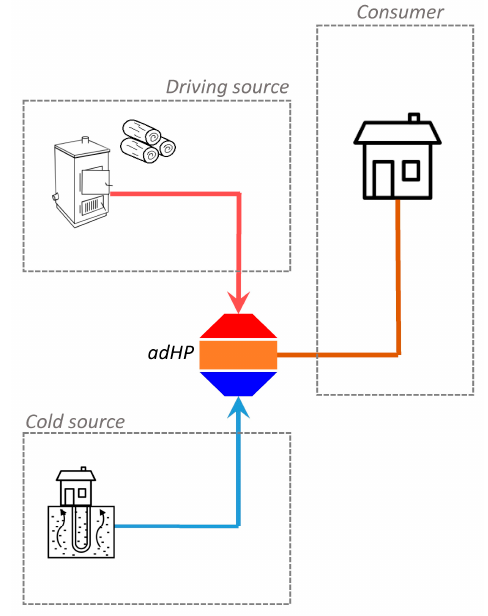
Figure 6. Schematic representation of the Scenario 3. Figure 7. Schematic representation of the Scenario